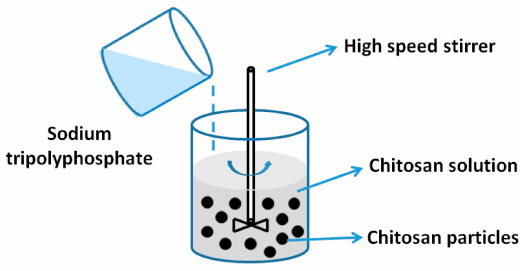
Figure 5. Preparation of chitosan NPs by ion gelation